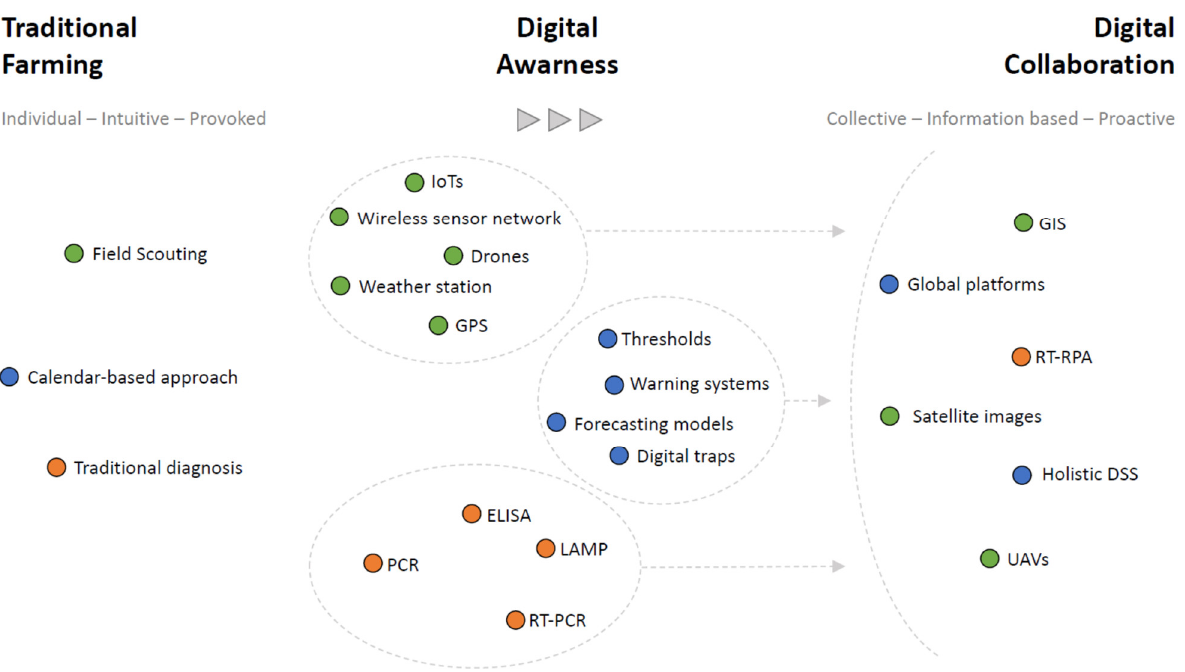
Figure 1. Digital roadmap leading to a digital collaboration era: the awareness of different digital tools available (monitoring tools—green, diagnostic tools—orange, and decision tools—blue) initiates the change from traditional farming (where the three areas are separated) to a more agile thinking (where different tools can be used, but the three areas are still separated) and finally, to a more collaborative architecture, where different tools of different areas can work together, enhancing each other.